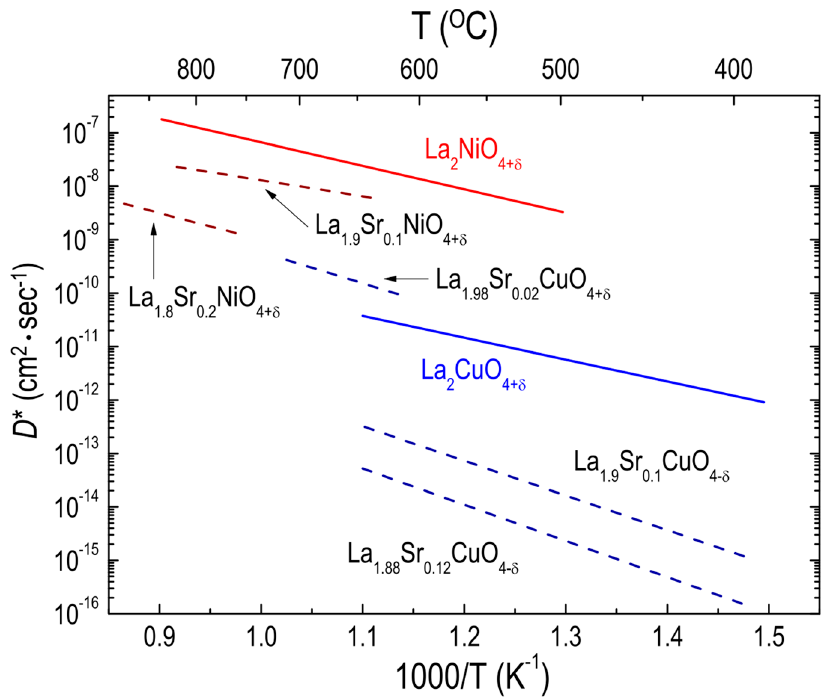
Figure 5. Arrhenius plots of oxygen tracer diffusivity ( D *) for different RP oxides. Effect of Sr substitution on the A site on D * for La 2 − x Sr x CuO 4+ δ (Ref. [56]) single crystal and La 2 − x Sr x NiO 4+ δ (Ref. [51]) polycrystalline oxides.